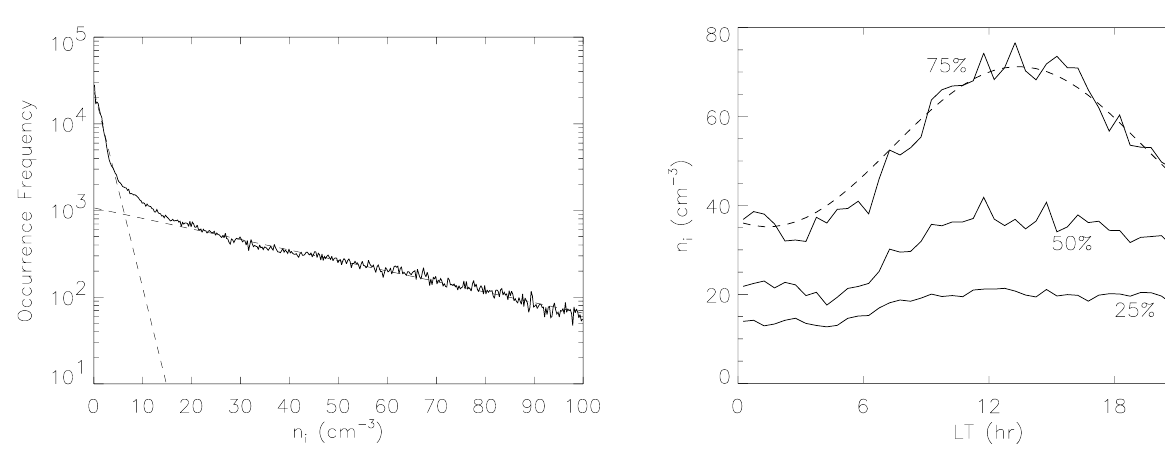
Fig. 4. The solid curves are the 25th, 50th and 75th percentile densi- ties, and the dashed curve is the best fit cosine to the 75th percentile, given by n( cm − 3 ) = 53 . 2 + 18 . 0cos (LT − 13 . 4 h )